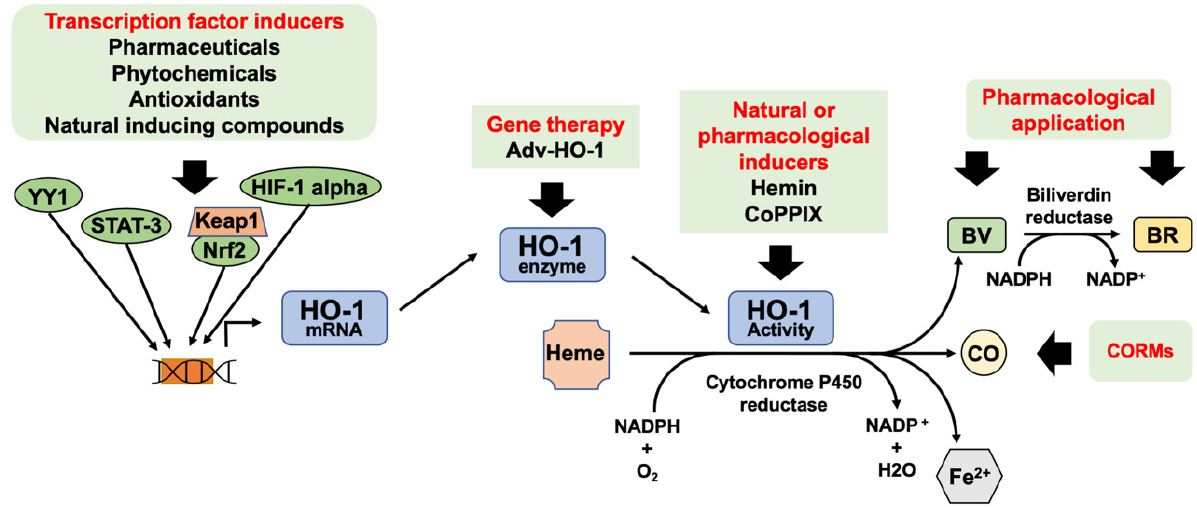
Figure 3. Potential therapeutic modulation of HO-1 and its enzymatic products for diabetic wound healing. HO-1 expression can be increased via activation of transcription factors or gene therapy. Natural or pharmacological inducers can be used to increase HO-1 enzymatic activity. CO, BV, and BR can be used as therapy. Legend: bilirubin (BR) biliverdin (BV), carbon monoxide (CO), CO-releasing molecules (CORMs), cobalt protoporphyrin IX (CoPPIX), heme oxygenase (HO-1), HO-1 gene transduction by adenovirus (Adv-HO-1), Kelch-like ECH-associated protein 1 (Keap1), nuclear factor erythroid 2–related factor (Nrf2).